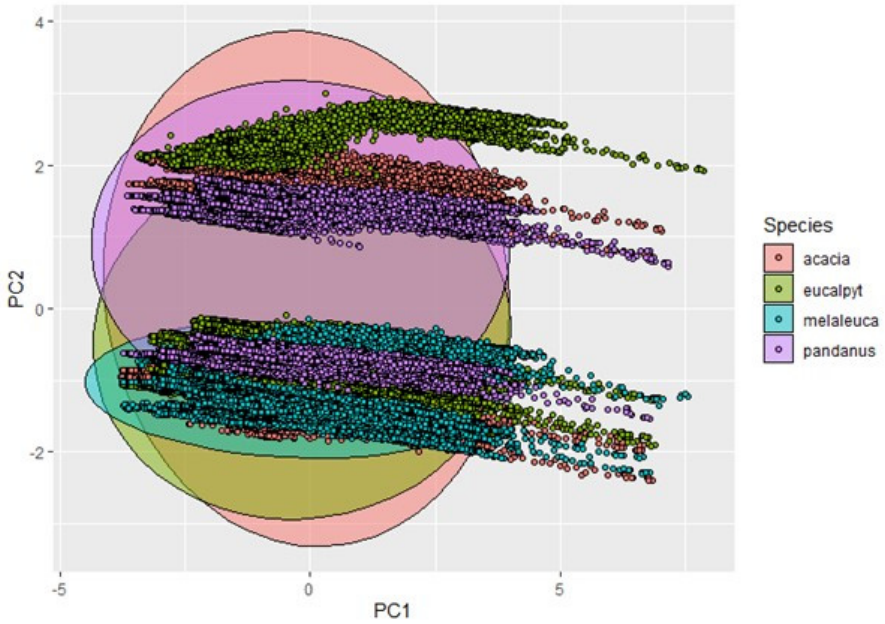
Figure 9. Score plot from the PCA, showing the influence of species and variability between indi- vidual trees on the PCA results. trees on the PCA